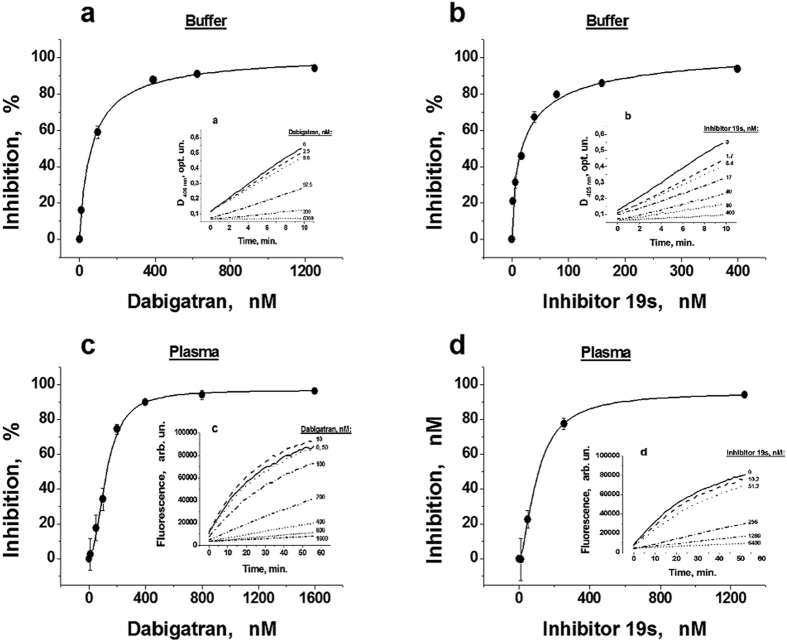
Effects of DTIs on thrombin calibrator (ThrCal) activity in a buffer system and plasma.(a,b) The percentage of inhibition for the hydrolysis rate of thrombin-specific chromogenic substrate by ThrCal (0.73 nM) in buffer solution in the presence of different concentrations of dabigatran or 19s, respectively. (c,d) The percentage of inhibition for the hydrolysis rate of thrombin-specific fluorogenic substrate in donor plasma in the presence of a constant ThrCal concentration (116.8 nM) and different concentrations of dabigatran or 19 s, respectively. Different plasma sets were used in the groups of different inhibitors. The inserts on the panels show the typical examples of product’s accumulation for corresponding experiments.